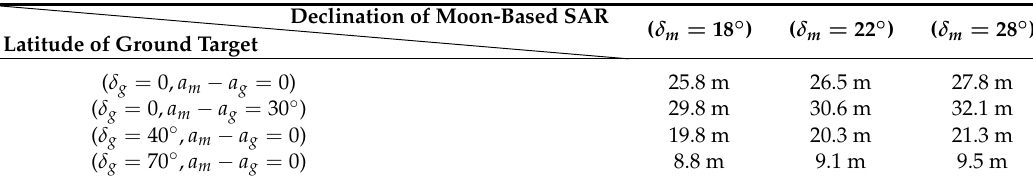
Table 3. Azimuthal Resolution of Simulation Results.